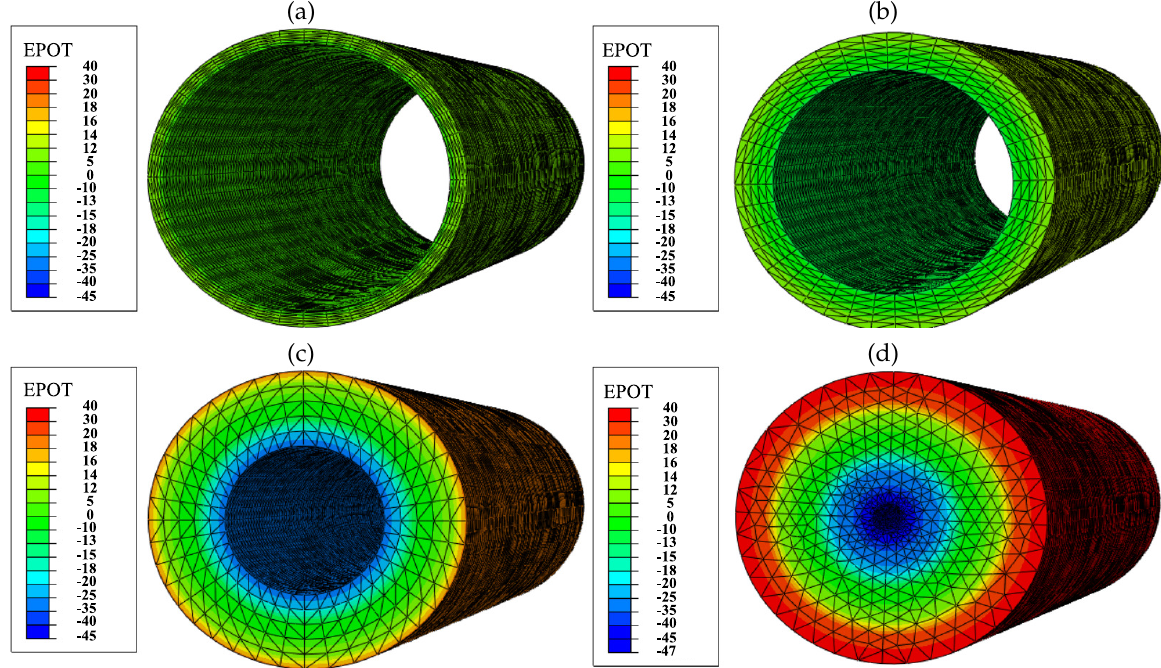
Figure 4. The electric potential (EPOT) [mV] generated by the PZE fiber with a longitudinal strain of 0.25. The electric potential has been evaluated for different wall thicknesses, corresponding to 2 µ m ( a ), 5 µ m ( b ), 10 µ m ( c ), and 18 µ m ( d